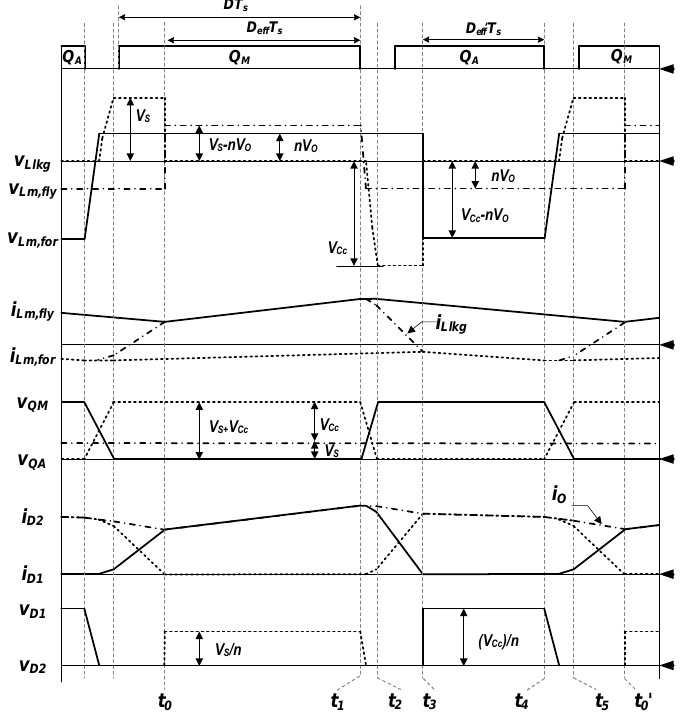
Figure 5. Key waveforms of ACFF LDC converter with integrated planar transformer.